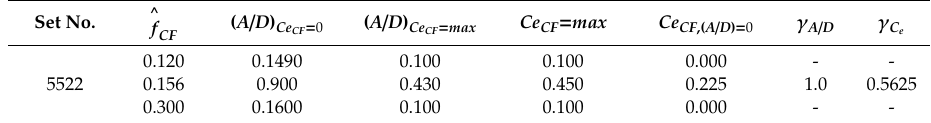
Table 9. Optimal excitation coe ffi cient parameters with modification factors for bare part of the riser. Set No.